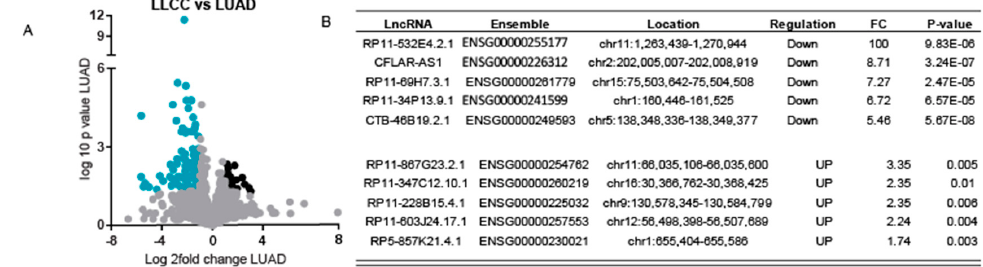
Figure 4. Expression difference in LCLC and LUAD. ( A ) A volcano plot to show the significantly differentially expressed LncRNA in LCLC as compared to LUAD. Black dots show overexpressed genes and blue dots show underexpressed LncRNAs. ( B ) List of top 5 underexpressed and top5 overexpressed LncRNA in LCLC compared to LUAD. ( C ) The Box plot representing the expression level of indicated LncRNAs. The whiskers show the 10th and 90th percentile of expression. ( D ) Curves representing results of ROC analysis performed to show the sensitivity and specificity of mentioned LncRNA in LCLC vs. LUAD tumors. 3. Discussion Large cell lung carcinoma (LCLC) have been classified as major lung cancer subtype by World Health Organization [12]. Although, LCLCs are very heterogeneous group of cancers, majority of LCLC patients are pooled with LUAD and LUSC for treatment [12]. Based on immunohistochemistry, two third of samples are grouped with LUAD or LUSC but remaining cases still remains unclassified [3]. Genetic aberration associate with LCLCs have been described but still there are no markers available for proper diagnosis of these patients. In present study, we utilized previously available high throughput RNA ‐ seq data and performed different statistical analysis to get a novel insight in LncRNAome of LCLC patient samples. Recently, growing body of evidence suggests that LncRNA play an essential role in all aspects of biology including cancer development and progression. There are multiple studies done on LncRNA profile in major subtypes of NSCLC i.e., LUAD and LUSC, but there is no study done on LCLC samples. In this regard, we perform first study to identify the LncRNAome of LCLC samples. In our analysis, we identified that only a small fraction of all annotated LncRNAs are expressed in LCLC samples. Interestingly, the LncRNA expressed in LCLC had a higher fraction of antisense LncRNA compared to Long intergenic RNA (LincRNA). Surprisingly, this bias was more evident in underexpressed LncRNA in LCLC, suggesting that antisense LncRNA may have different regulation than the LincRNAs. In this study, we also showed that LncRNAs can discriminate between cancerous and normal samples with very high sensitivity and specificity. Due to high sensitivity and specificity, LncRNAs can be potential marker for the development of novel diagnostic markers for the LCLC neoplasm. In